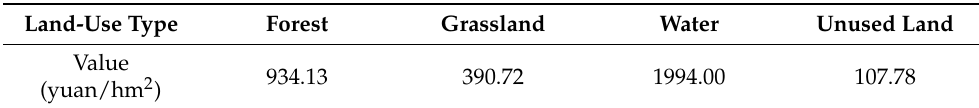
Table 4. Tourism leisure value per unit area of Ecosystem in China (yuan/hm 2 ). Land-Use Type Forest Grassland